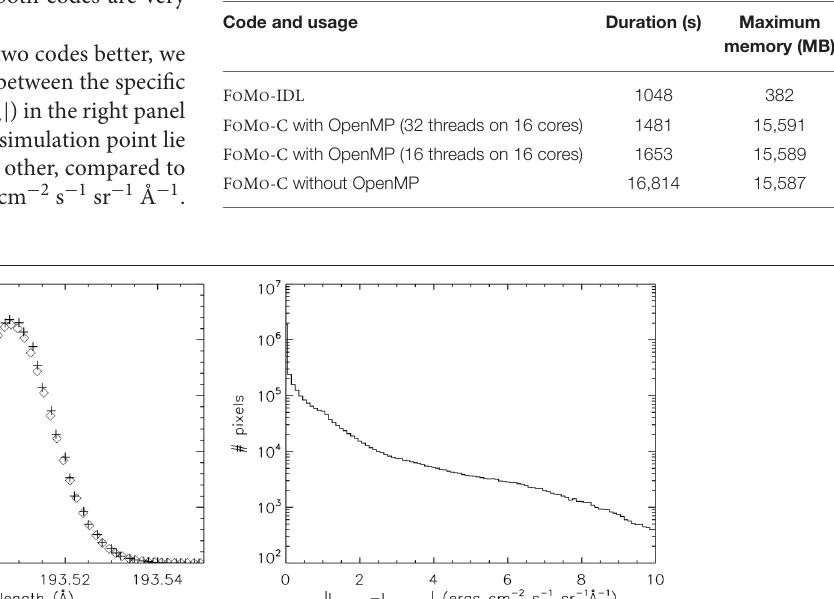
TABLE 2 | Performance of the FoMo-C and FoMo-IDL